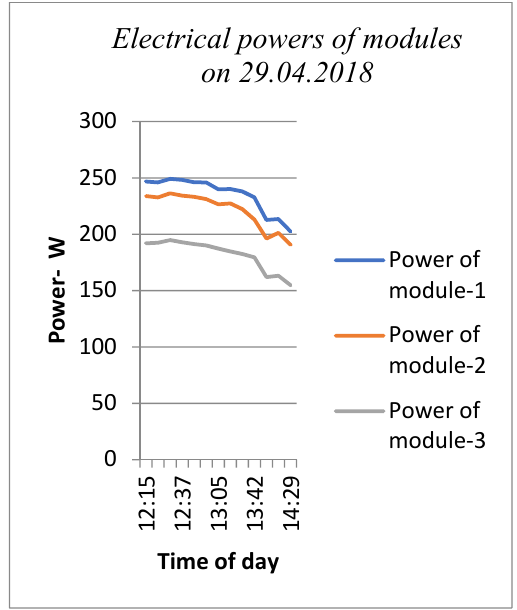
Figure 8. Electrical powers of modules on 29.04.2018.